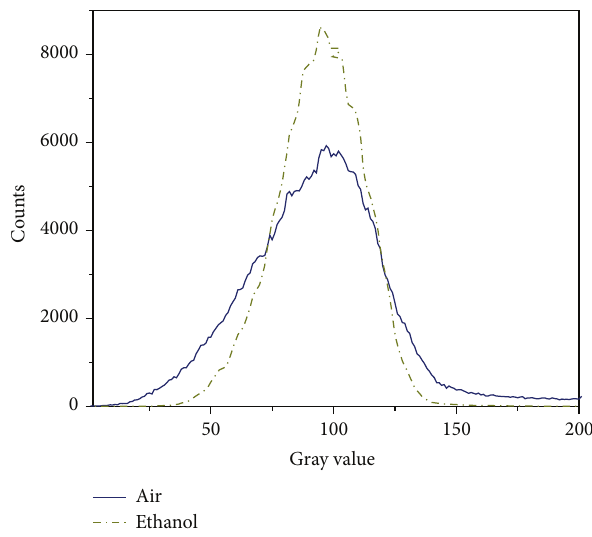
Figure 9: Analysis of light intensity across the fingerprint structure before and after ethanol